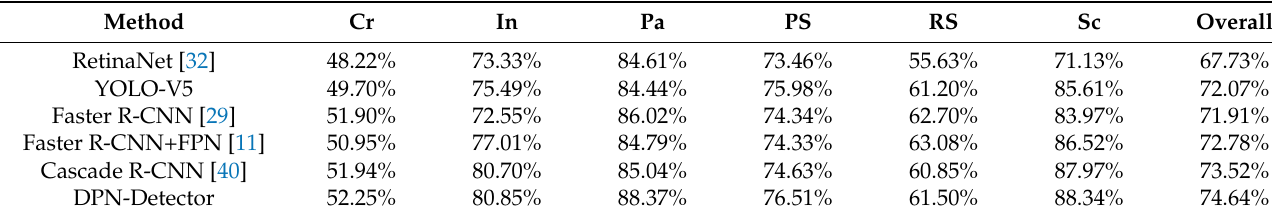
Table 2. The F1 comparison of different detectors.